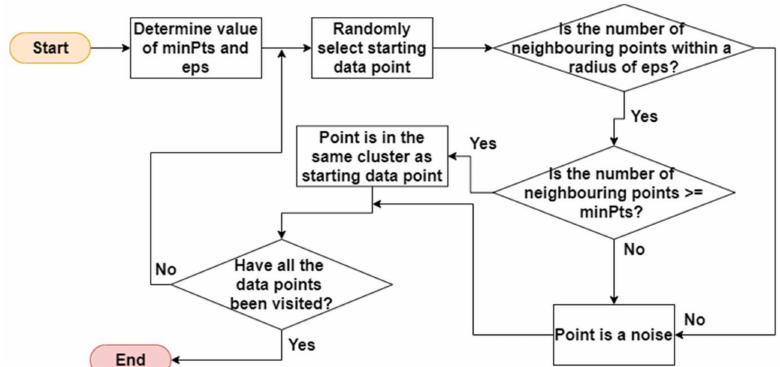
Figure 7. Basic steps of DBSCAN